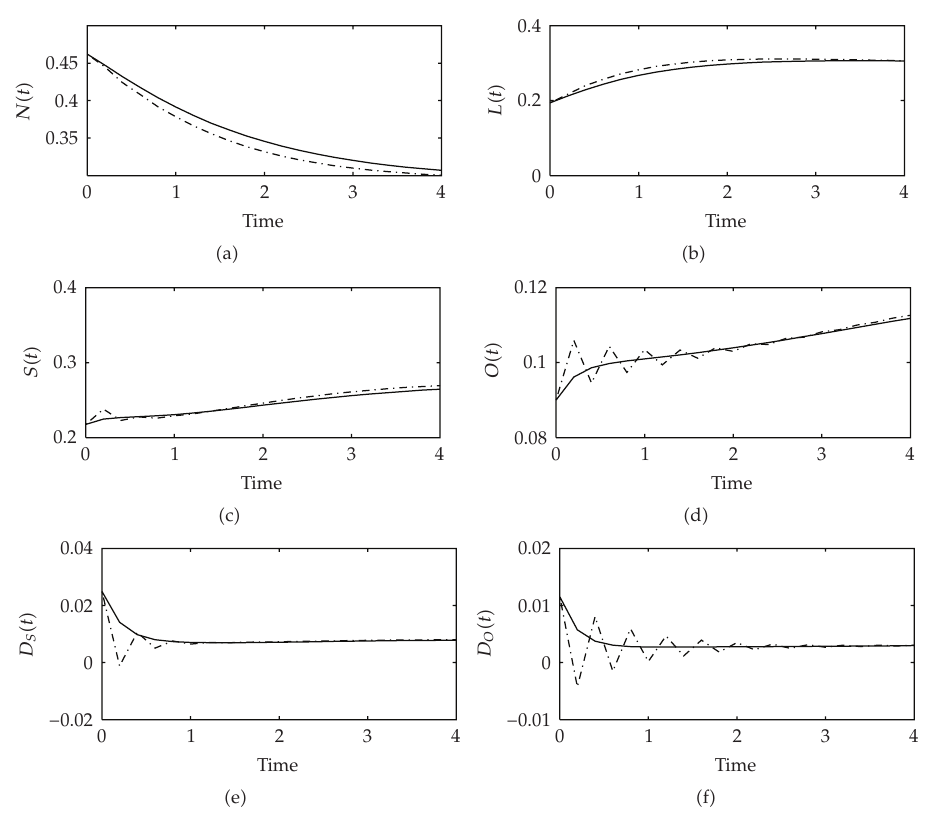
Figure 3: Profiles of subpopulations N (cid:3) t (cid:6) , L (cid:3) t (cid:6) , S (cid:3) t (cid:6) , O (cid:3) t (cid:6) , D S (cid:3) t (cid:6) , and D O (cid:3) t (cid:6) . Solutions are obtained by Euler (cid:3) dashed (cid:6) and proposed NSFD scheme (cid:3) line (cid:6) with ψ (cid:3) h (cid:6) (cid:7) h and h (cid:7) 0 . 2 for system (cid:3) 2.1 (cid:6) .